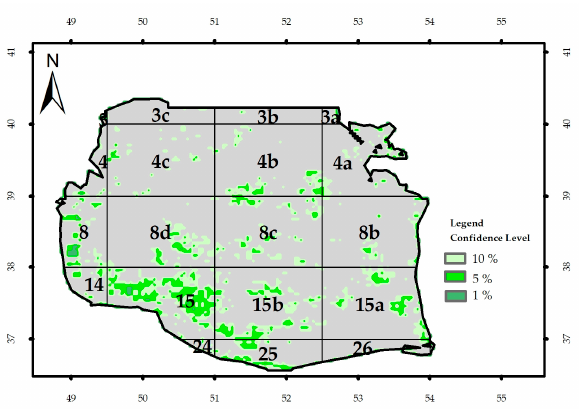
Figure 4. T-score for three confidence levels (99%, 95%, and 90%) in relation to Kd_490nm and Rrs_555nm in different blocks of the Southern Caspian Sea (SCS).